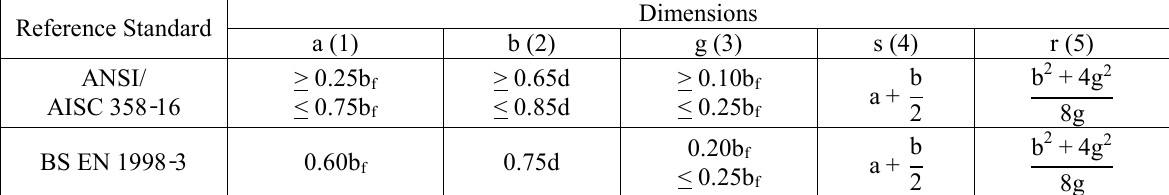
Comparison of the geometric